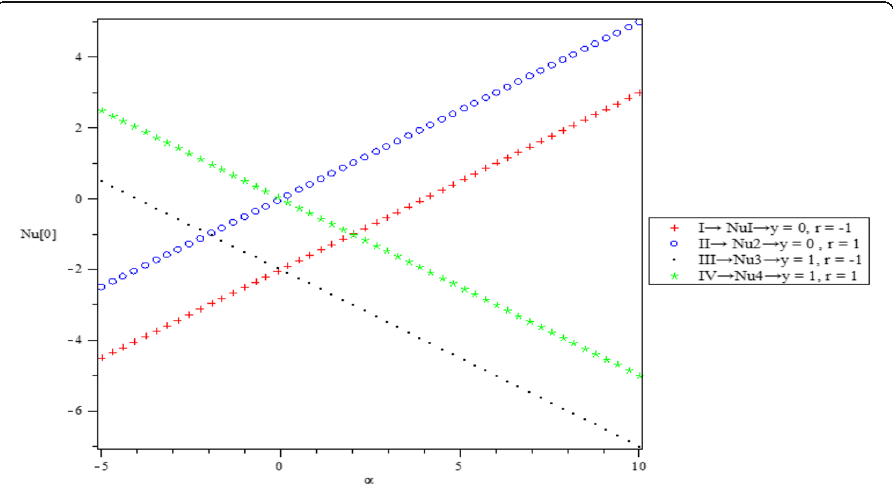
Fig. 10 Zeroth-order Nusset number (Nu[0] when β =